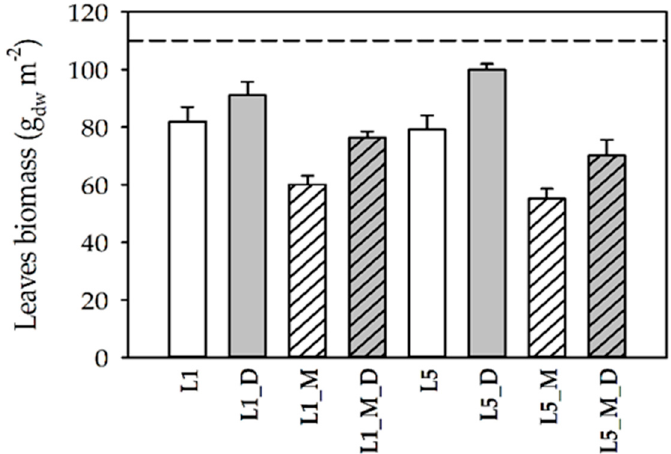
Figure 3. Remaining leaf biomass recovered at the end of the experimental period. Mean ± standard error ( n = 5) are reported. The horizontal dashed line is the reference value of the average leaf biomass at the beginning of the experiment.